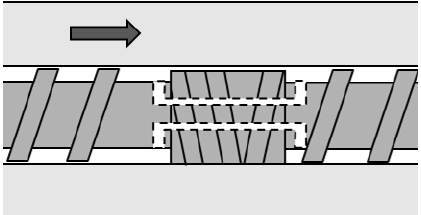
Figure 4. Screw elements with through-holes. The arrow indicates the flow direction of resin.